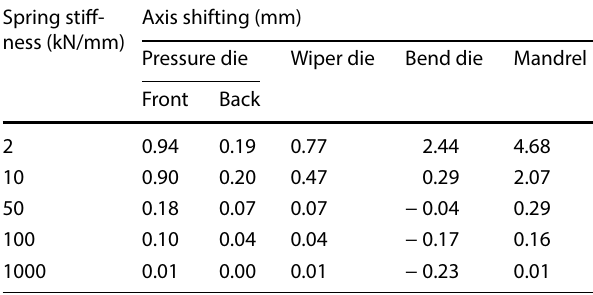
Table 2 Axis shifting with a pressure die distance of 1 mm Spring stiff- Axis shifting ness (kN/mm)